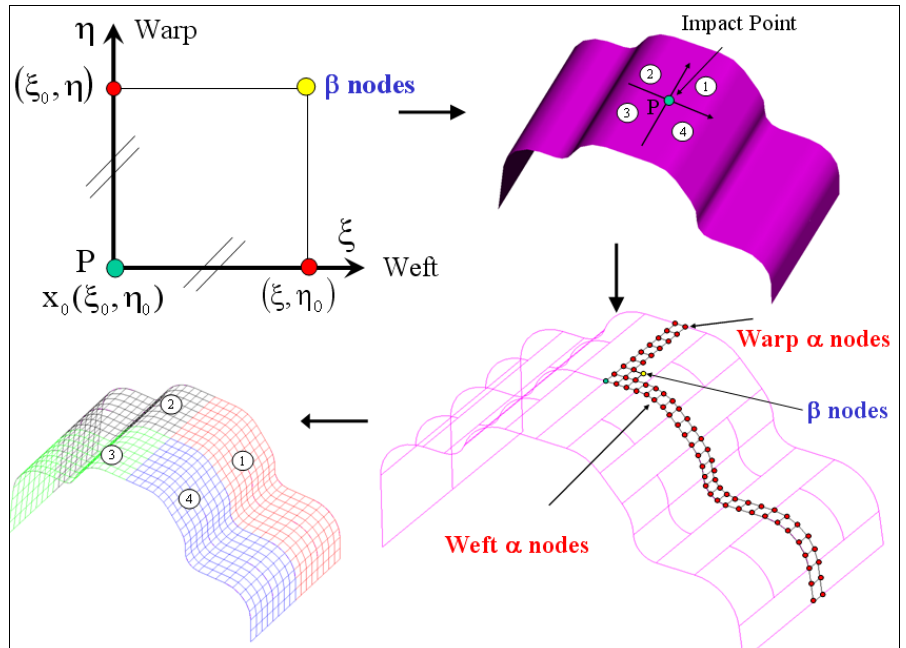
Figure 1. Geometrical draping of composite